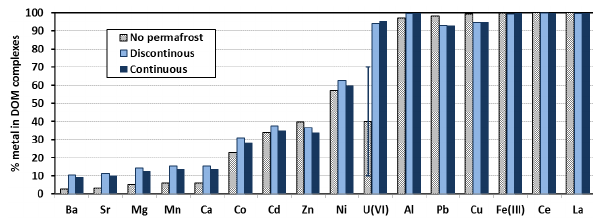
Figure 11. Percentage of organic complexes in western Siberian rivers (<0.45µm fraction) calculated using the Stockholm Humic Model (vMinteq, version 3.1; Gustafsson, 2014). Values of major and trace elements measured in 66 rivers in the permafrost-free zone, 110 rivers in the discontinuous permafrost zone and 39 rivers in the continuous permafrost zone averaged over all seasons were